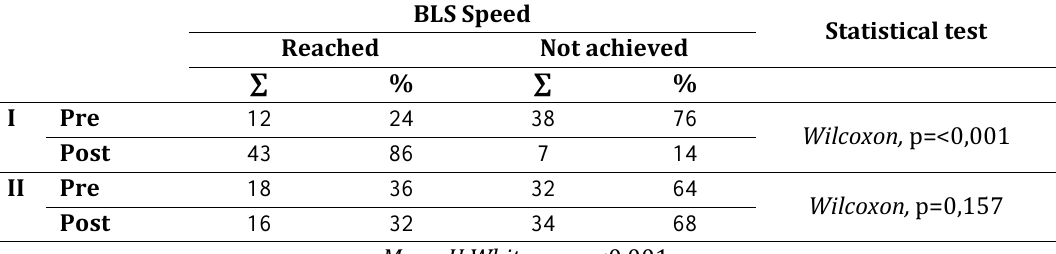
BLS Speed of Emergency Room at Public health